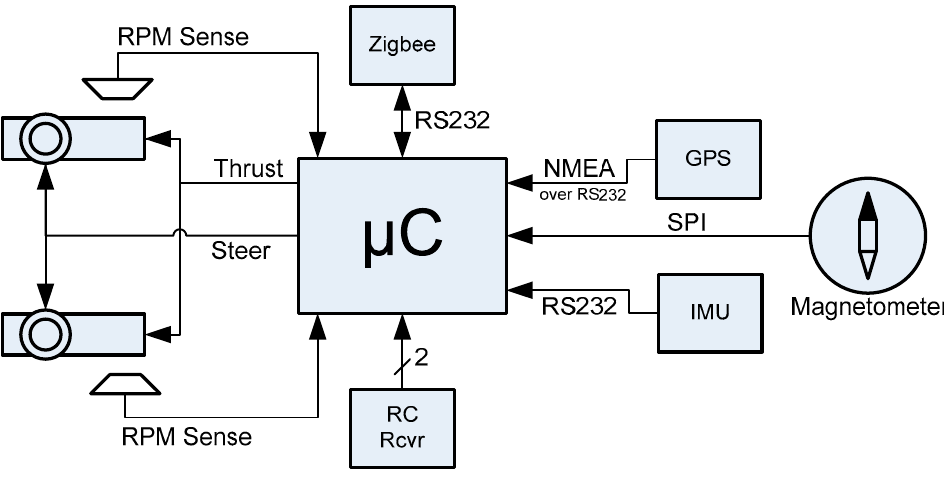
Figure 4. Control system structure.